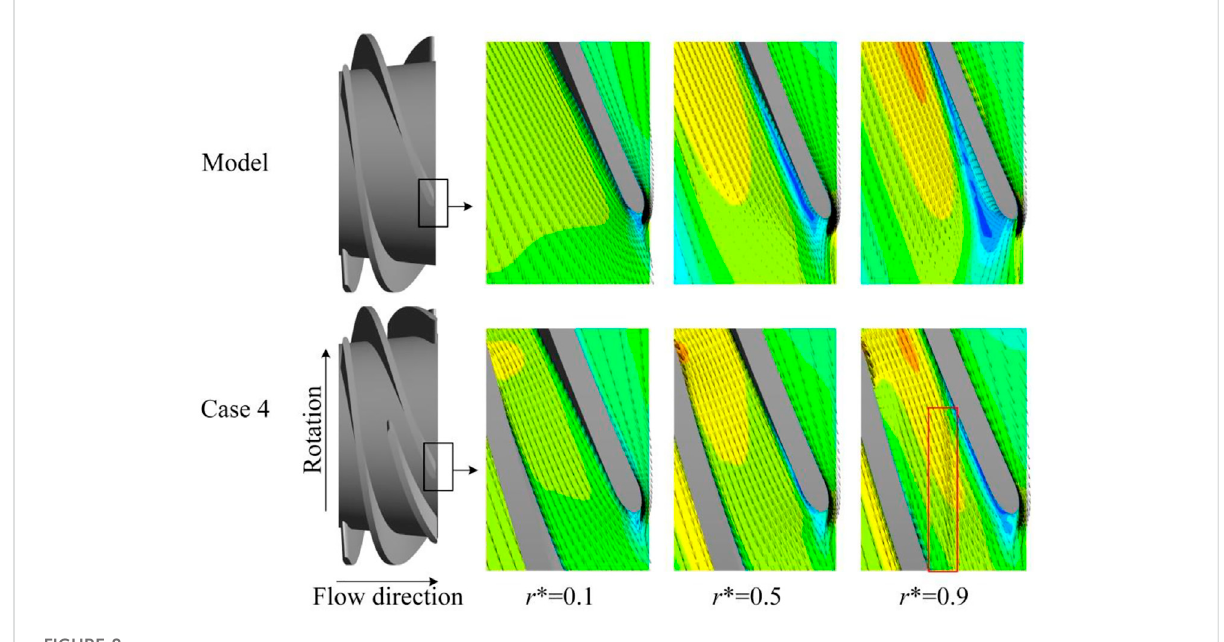
FIGURE 8 Velocity contour and vector of the impeller outlet before and after complex